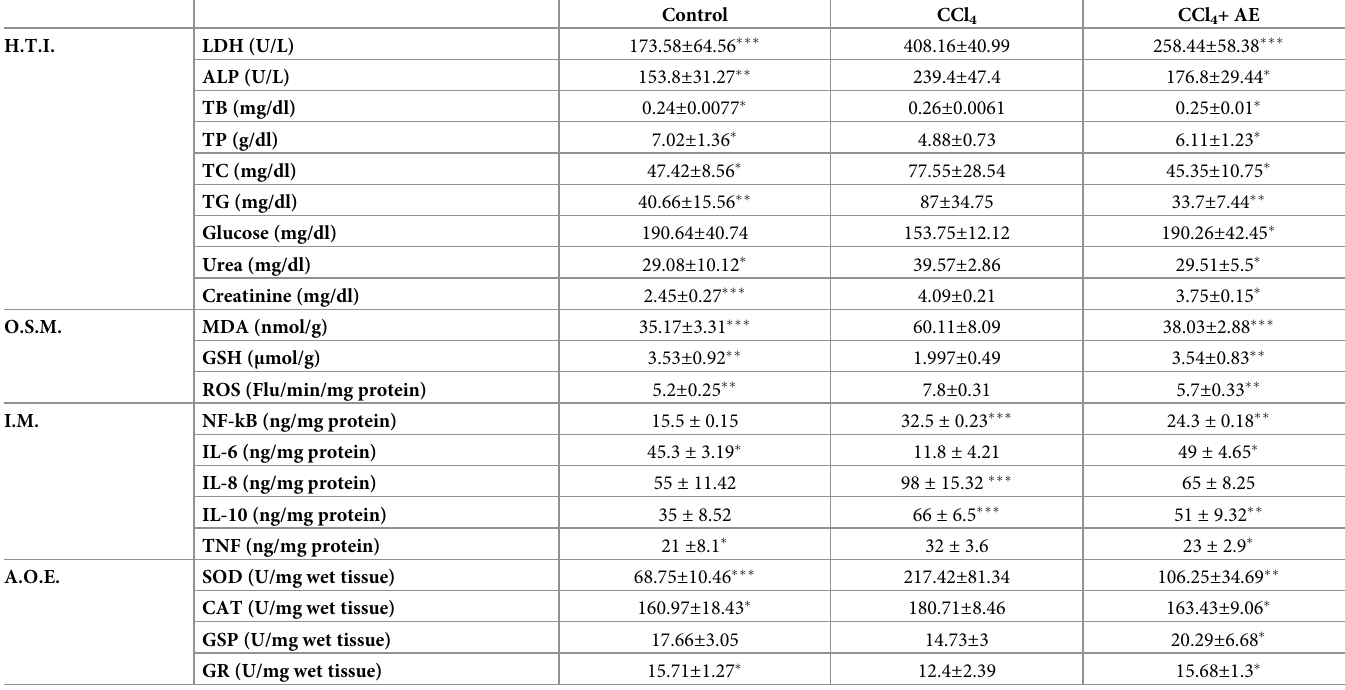
Table 6. Effect of P . niruri AE (100 mg kg -1 day -1 ) on hepatic toxicity indices, oxidative stress markers, inflammatory markers and antioxidant enzymes after rats acute